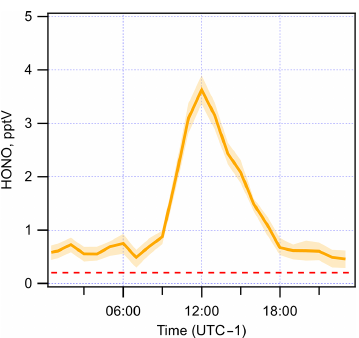
Figure 2. The observed average HONO diurnal measured at CVO during 24 November–3 December 2015. Shaded area indicates stan- dard deviation and cumulative error of data. Dashed red line shows the HONO limit of